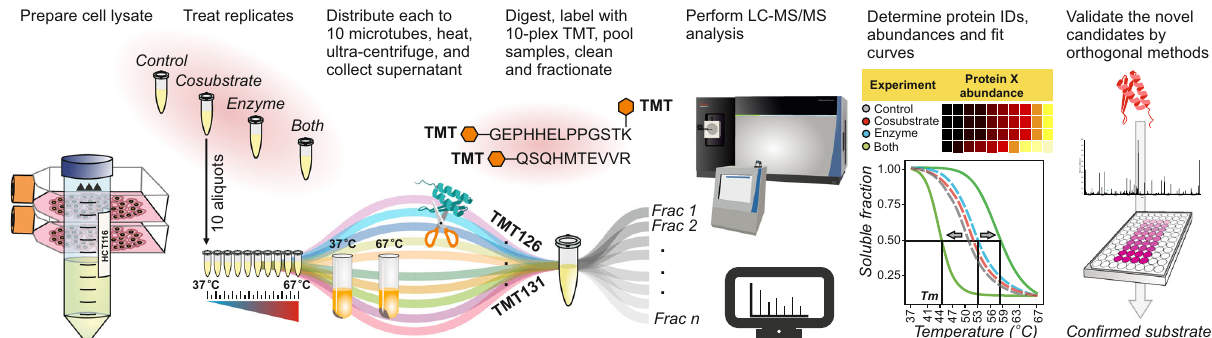
Fig. 1 SIESTA work fl ow for unbiased proteome-wide identi fi cation and prioritization of enzyme substrates. A master cell lysate is prepared by multiple freeze-thawing in a non-denaturing buffer. The cell lysate aliquots are treated with vehicle (control), cosubstrate, enzyme, or combination of enzyme with cosubstrate (both). After treatment, each aliquot is split into ten tubes, with each tube heated to a temperature point in the range from 37 to 67 °C. After removing unfolded proteins by ultracentrifugation, identical volumes of supernatants are digested with trypsin. The samples are then serially labeled with 10-plex tandem mass tag (TMT) reagents, pooled, cleaned, and fractionated by reversed-phase chromatography. After LC-MS/MS analyses of each fraction, protein IDs and abundances are determined, and sigmoid curves are fi tted through an automated algorithm to determine the melting temperature ( T m ) for each protein. For each non-vehicle treatment, the read-out is the protein ’ s Δ T m shifts (of both signs) compared to control. Any protein shifting more upon addition of enzyme and cosubstrate compared to when they are added alone, are putative substrates of the enzyme under study. Such candidate protein substrates are subsequently con fi rmed by orthogonal veri fi cation methods, starting from the proteins exhibiting largest Δ T m shifts and/ or involved in relevant